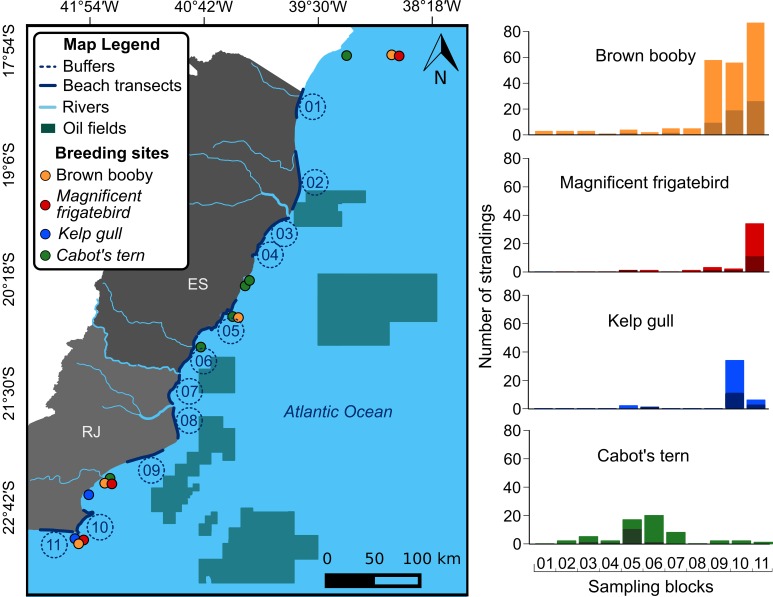
Panel summarizing the study design and seabird stranding events.The left panel shows the 11 transects covered to record seabird carcasses and adjacent buffers from where we extracted the average values of the variables used to predict stranding events along the South-eastern coast of Brazil. The right panel shows histograms indicating strandings for the four resident seabird studied species along the 11 transects. Dark and light shades indicate juveniles and adults, respectively.